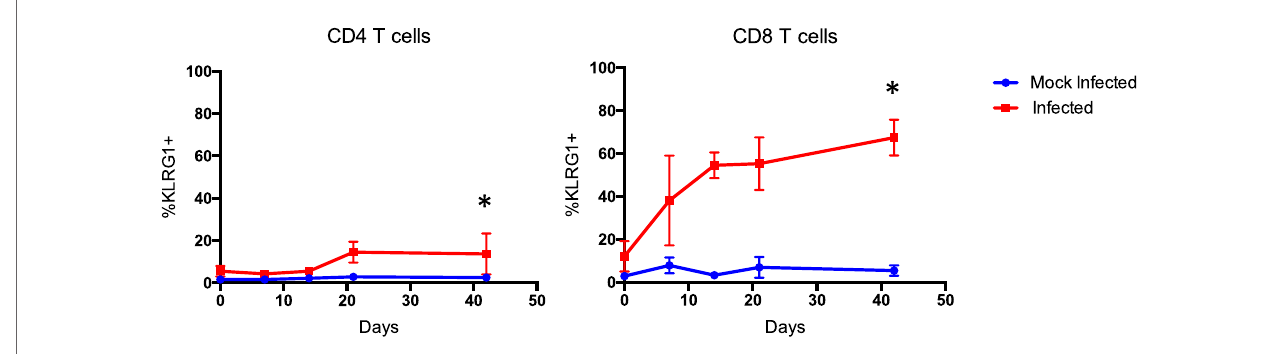
FigUre 5 | Terminally differentiated cells arise following multiple infections. Expression of KLRG1 was significantly upregulated on CD4 ( p < 0.0126) and CD8 T cells ( p < 0.0001, calculated using two-way ANOVA) of mice that received all three infections compared with mice that received mock infections ( n = 10 per